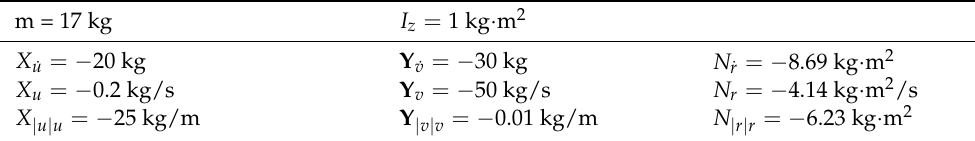
Table A1. Mass, inertia and hydrodynamics coefficients for a MEDUSA vehicle.